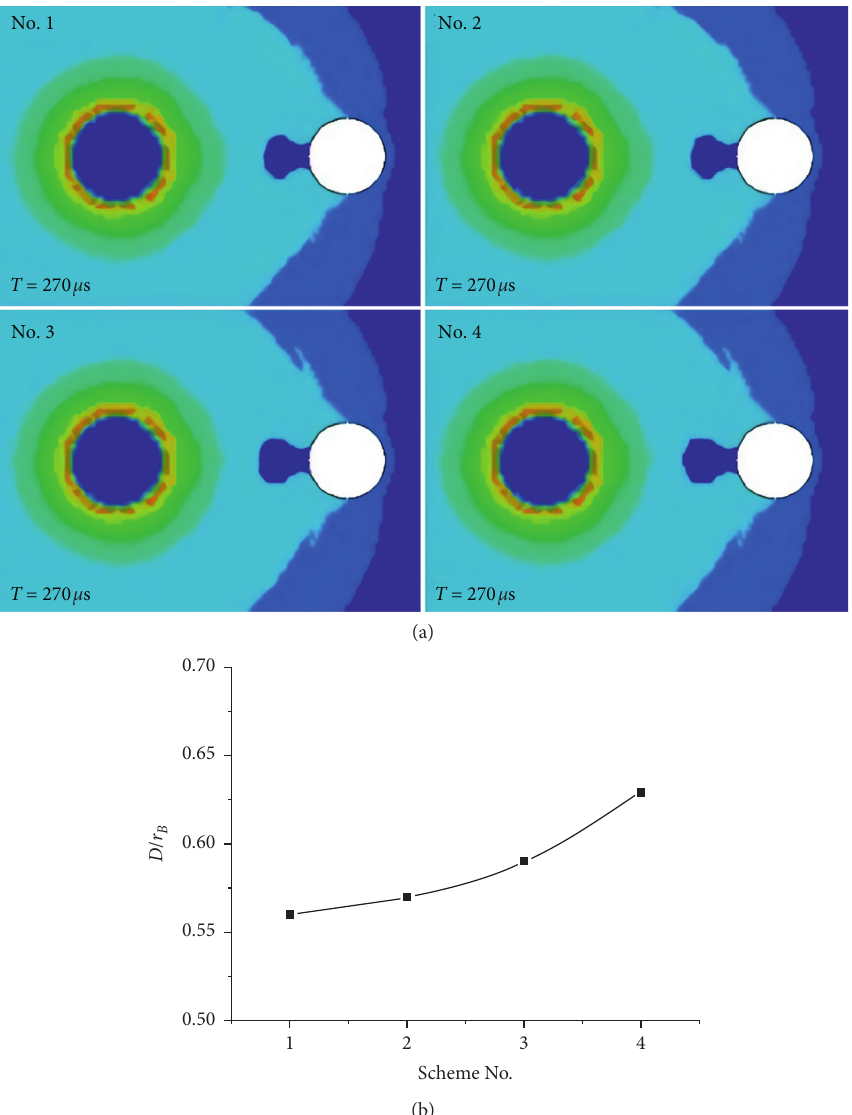
Figure 8: Cloud chart of dynamic stress distribution around the empty hole in combined stress field and curves of changes in tension zone for Scheme III. (a) Cloud chart of dynamic stress distribution in combined stress field. (b) Changes in the tension